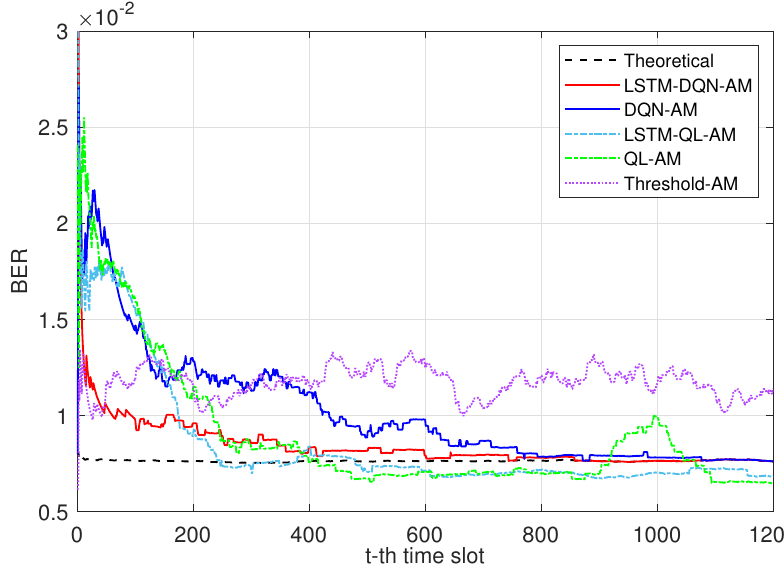
Figure 9. The BER of the AM schemes in the pool experiments.